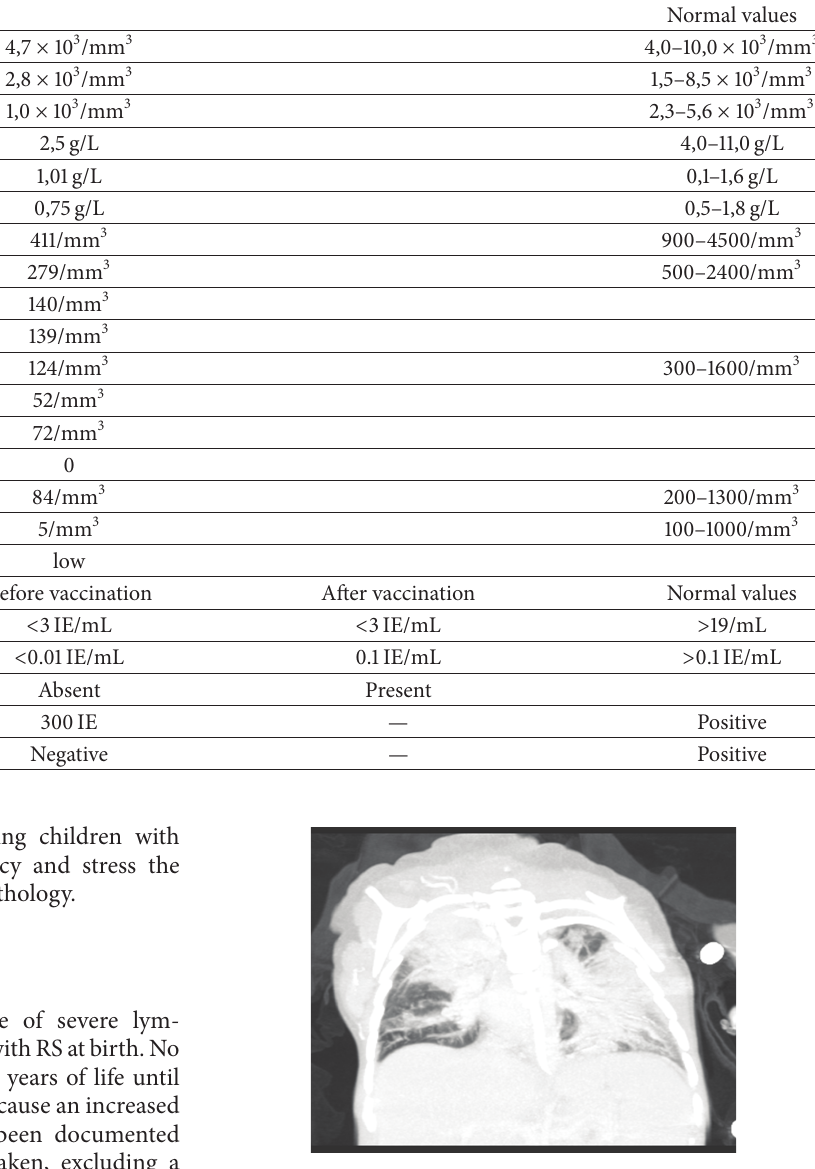
Table 1: Immunological work-up.